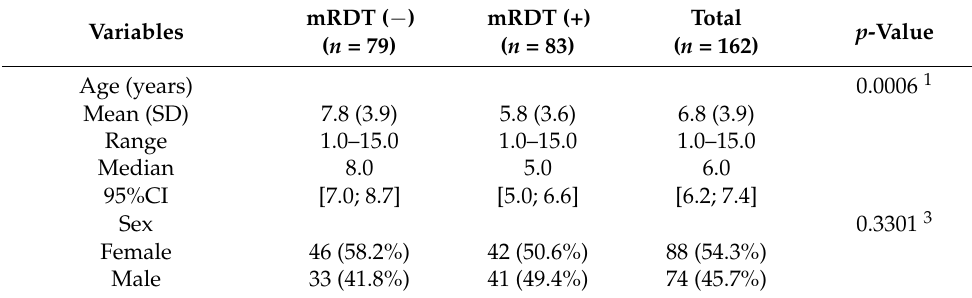
Table 1. Characteristics of asymptomatic children ( n =